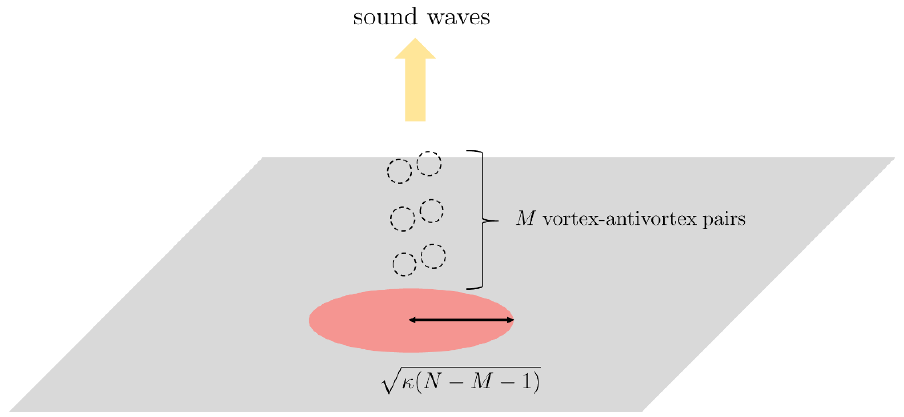
M ) electrons form −